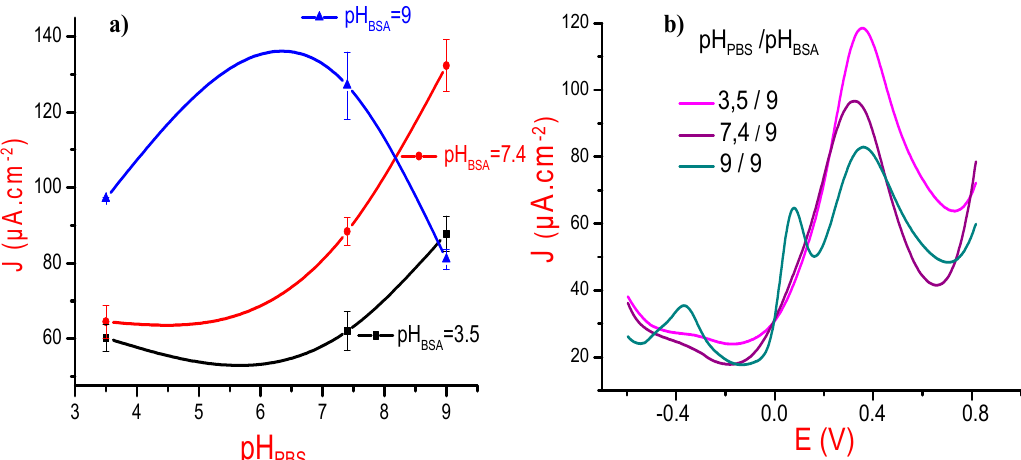
Figure 4. ( a ) Variations of the maxima of MIP current density versus the pH of the supporting electrolyte (pH PBS ). pH values of BSA solutions used during the realization of the MIPs were equal to 3.5 (black curve), 7.4 (red curve), and 9.4 (blue curve). ( b ) Square wave voltammetry (SWV) voltammograms of MIPs designed with BSA protein solution at a fixed pH (pH BSA = 9) and characterized at three different pH values of the PBS solution (pH PBS = 3.5, 7.4, and 9). All experiments were done at a fixed ionic strength (I = 167 mM) and at BSA concentration equal to 10 − 1 mg/mL.